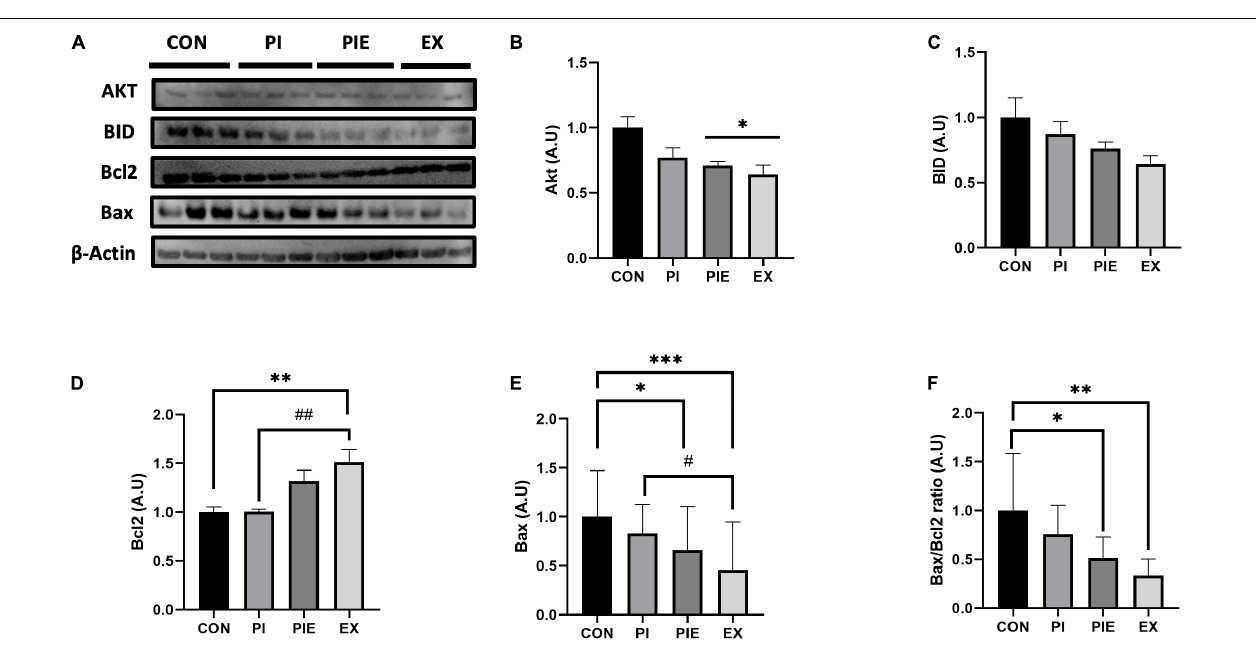
FIGURE 11 | Exercise can ameliorate apoptosis-related markers during PM exposure and exercise in the lung. (A) Representative western blot images of Akt, BID, and Bcl2. Western blot analysis was performed to assess the effect of PM exposure on Akt (B) , BID (C) , Bcl2 (D) , Bax (E) , and Bax/Bcl2 ratio (F) . Values are